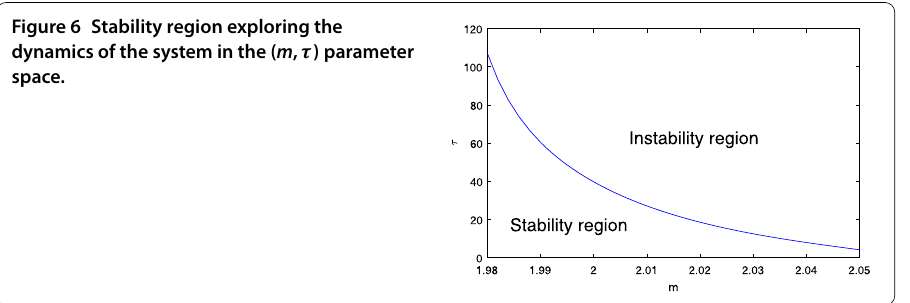
Figure 6 Stability region exploring the dynamics of the system in the ( m , τ ) parameter